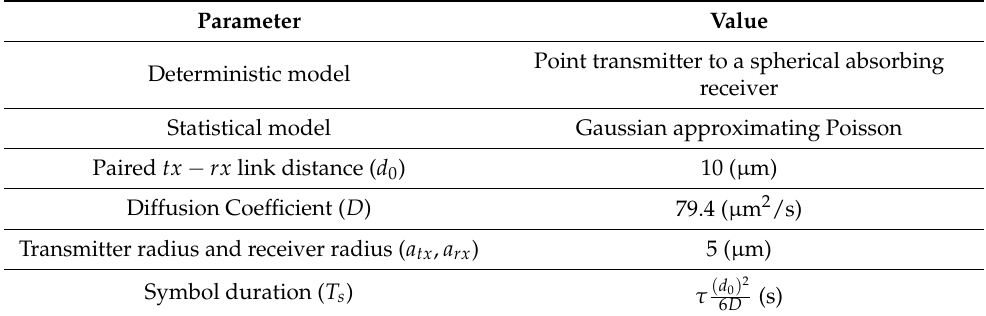
Table 1. Simulation